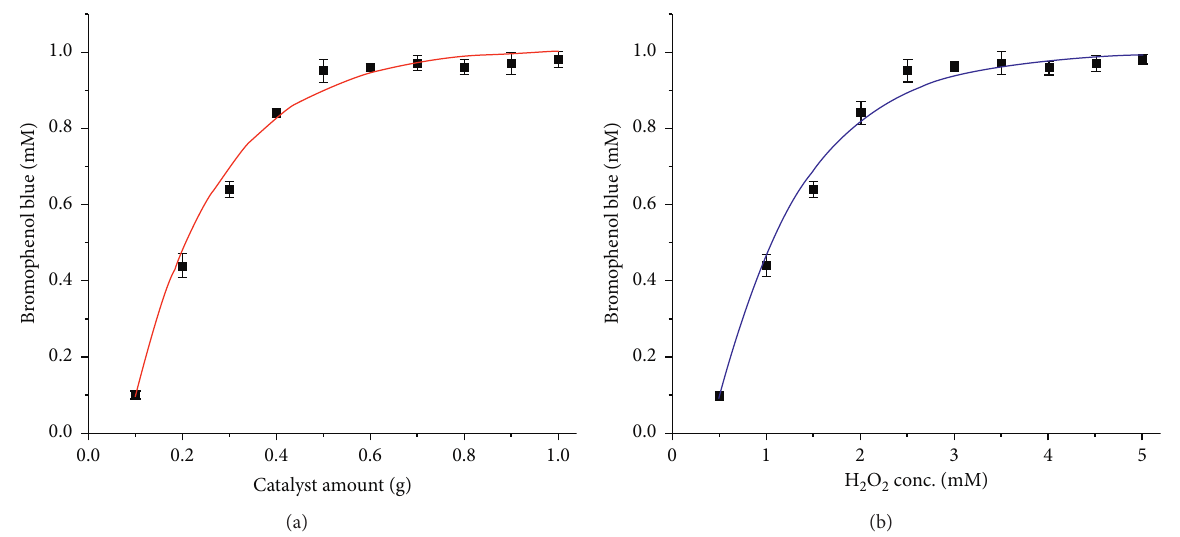
Figure 21: Effect of (a) amount of catalyst (Fe 3 O 4 @SiO 2 @LEuH@PW 10 ) and (b) amount of H 2 O 2 used in bromination of phenol red to bromophenol blue. Reaction conditions are as follows 10 ml of 1.0mM phenol red in water+10ml of 10.0mM NH 4 Br in water +2.5mM H 2 O 2 in reaction a +0.5g of catalyst in reaction b, in a round-bottomed flask. Time � 10 minutes, T � 298K, and P � 1atm.